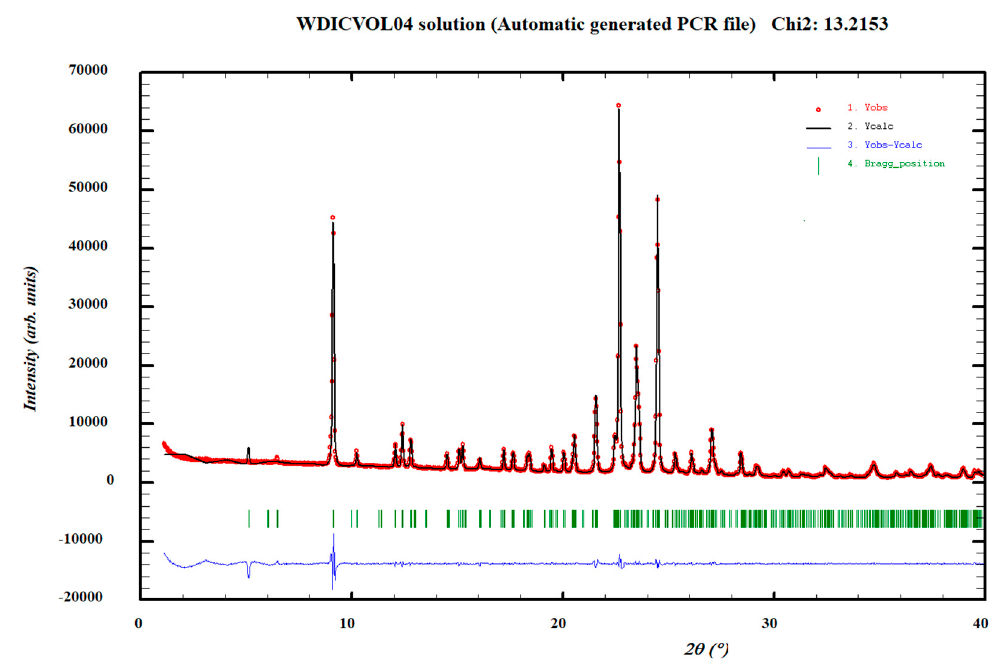
6 of 15 Figure 2. Pattern matching refinement of the Norfloxacin–resorcinol cocrystal. Agreement factors: R wp : 9.5%; R exp : 1.7% (Chi 2 = 33). Experimental XRPD profile (red marks), calculated XRPD profile (black solid line) and the difference between them (blue, line). Tick marks correspond to peak posi- tions (|, in green). The powder diffractogram of the Norfloxacin–resorcinol cocrystal monohydrate was